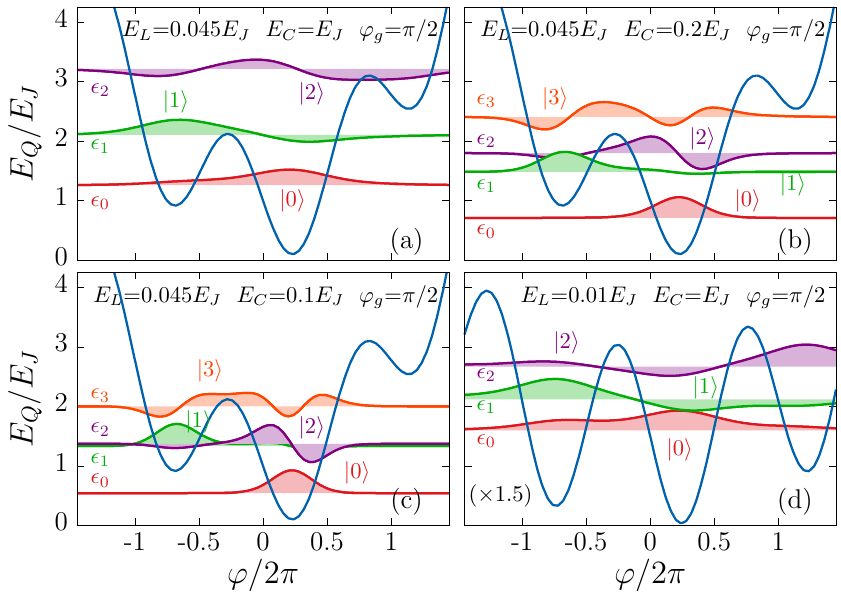
Figure 3. The potential energy (3) of the chiral magnetic qubit with the chiral magnetic Josephson junction possessing the phase offset ϕ g = π /2 for various Coulomb charging energies E C and inductive energies E L : ( a ) E C = 0.045 E J , E L = E J ; ( b ) E C = 0.045 E J , E L = 0.2 E J ; ( c ) E C = 0.045 E J , E L = 0.1 E J ; and ( d ) E C = 0.01 E J , E L = E J . Lowest eigenstates | n (cid:105) with n = 0,1, . . . are shown along with the numerically computed energy levels ε n and the corresponding wavefunctions ψ n ( ϕ )